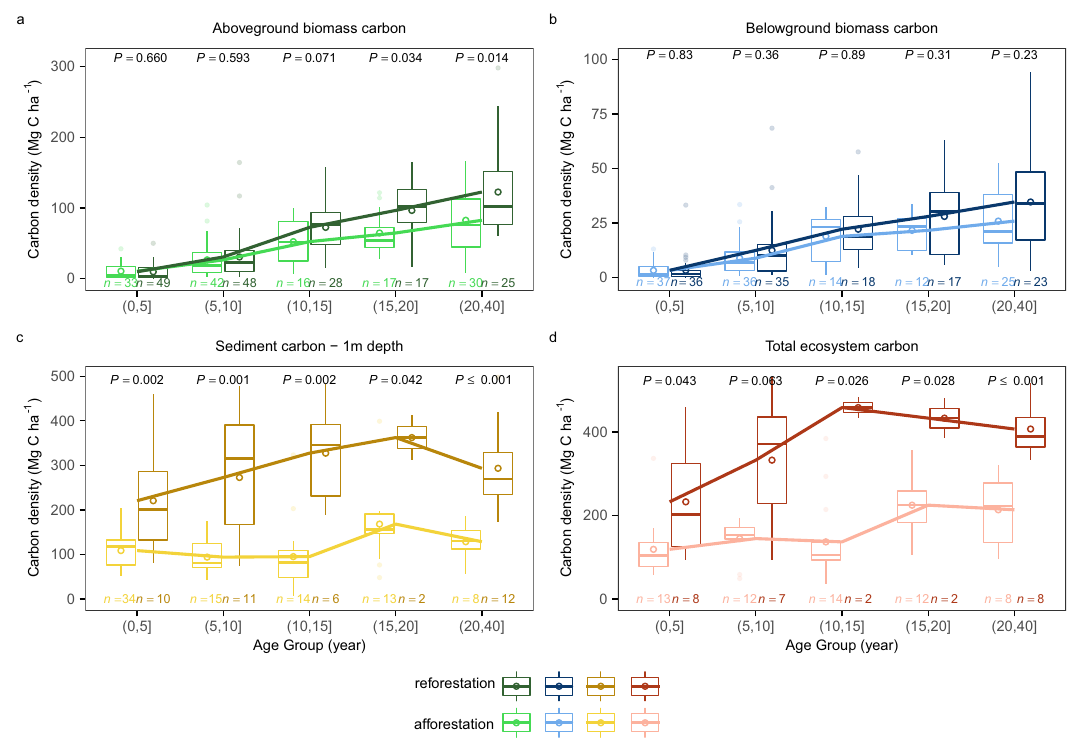
Fig. 2 | Comparison of carbon density between mangrove reforestation and afforestation projects over a 40-year period. a Aboveground biomass carbon, b Belowground biomass carbon, c Sediment carbon to a depth of 1m, d Total ecosystem carbon. The x-axis represents different age groups (0 – 5, 5 – 10, 10 – 15, 15 – 20, and 20 – 40 years). For each box plot, components are as detailed in Fig. 1. Outliers are represented by dots. The mean carbon density in each time group is